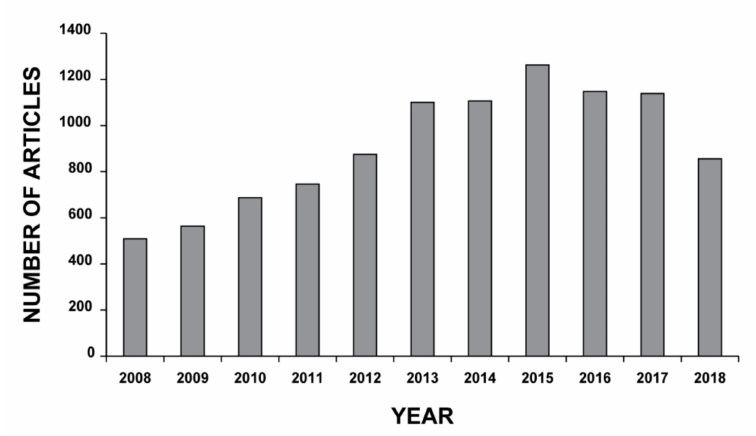
Figure 4. Mesenchymal stem cell-based therapy. Search for article appearing in PUBMED database over the past 10 years using the mesh terms “Mesenchymal Stem Cells” AND “Cell- and Tissue-Based Therapy” in the Advance research builder